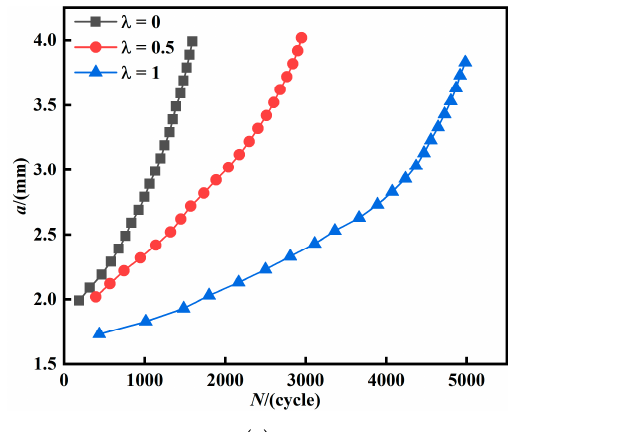
Figure 9. a-N curves under crack inclination β = 60°, 45°. ( a ) a-N curves ( β = 60°), ( b ) a-N curves ( β = 45°).